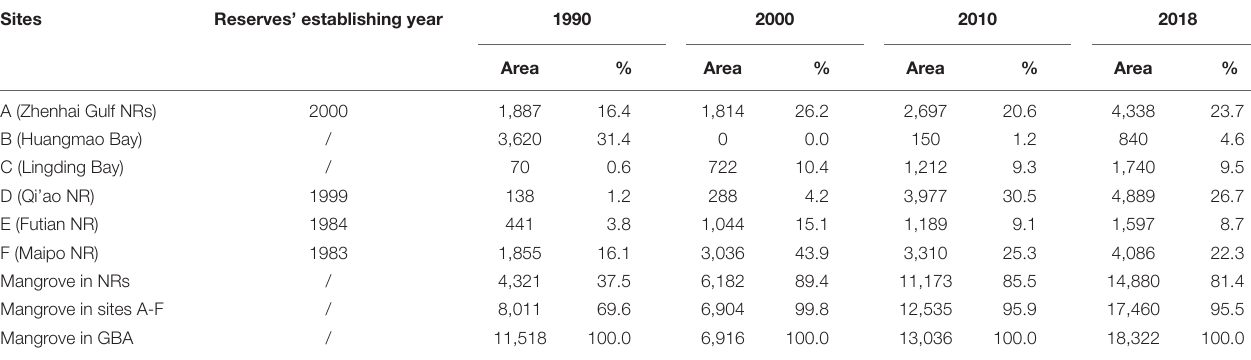
TABLE 2 | Estuarine mangrove areas (ha) and proportion (%) for each site.